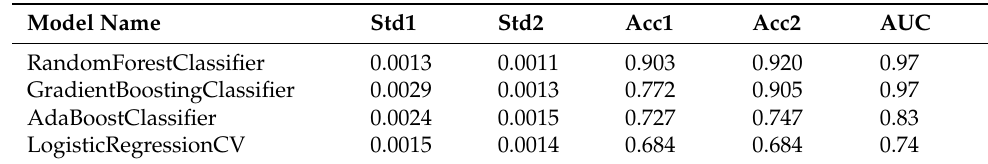
Table 2. Model evaluation of unclassified landslides, standard deviation, preliminary test accuracy, optimized test accuracy, and AUC score.